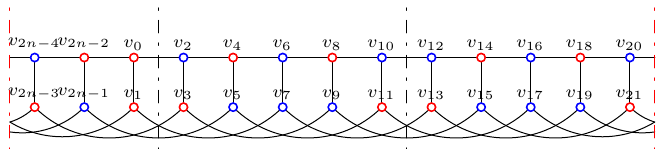
Figure 12. Segment of f in Case 2.1.1 in Lemma 8.